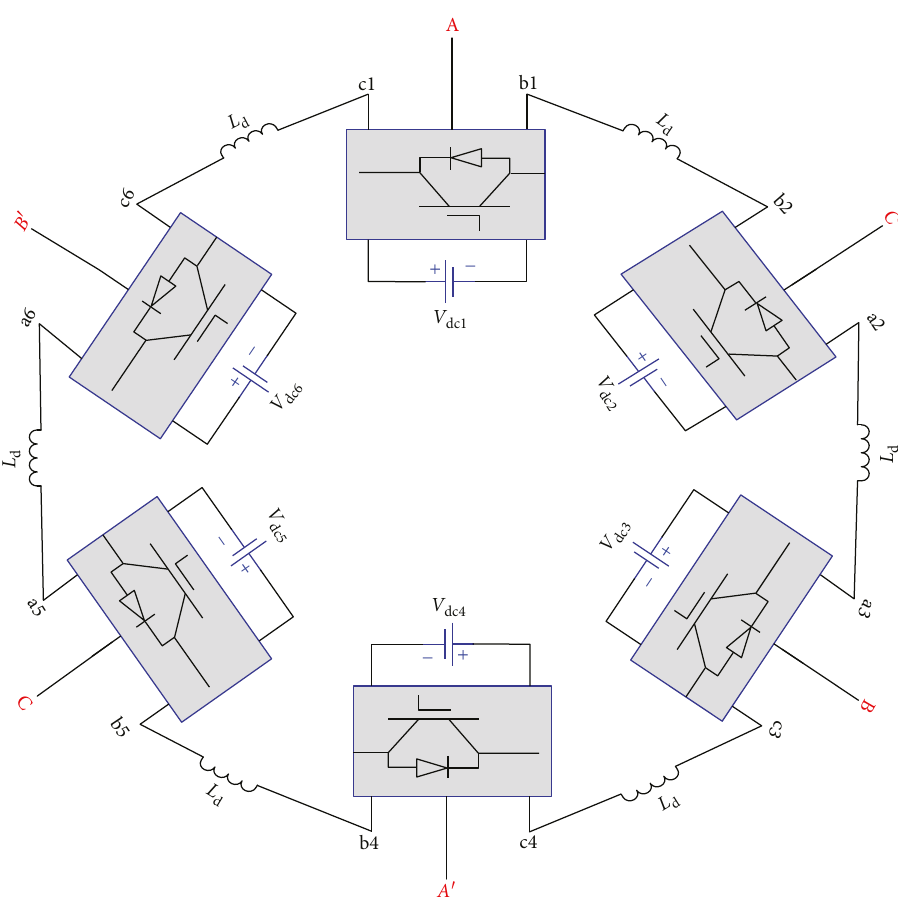
Figure 2: HMC electrical